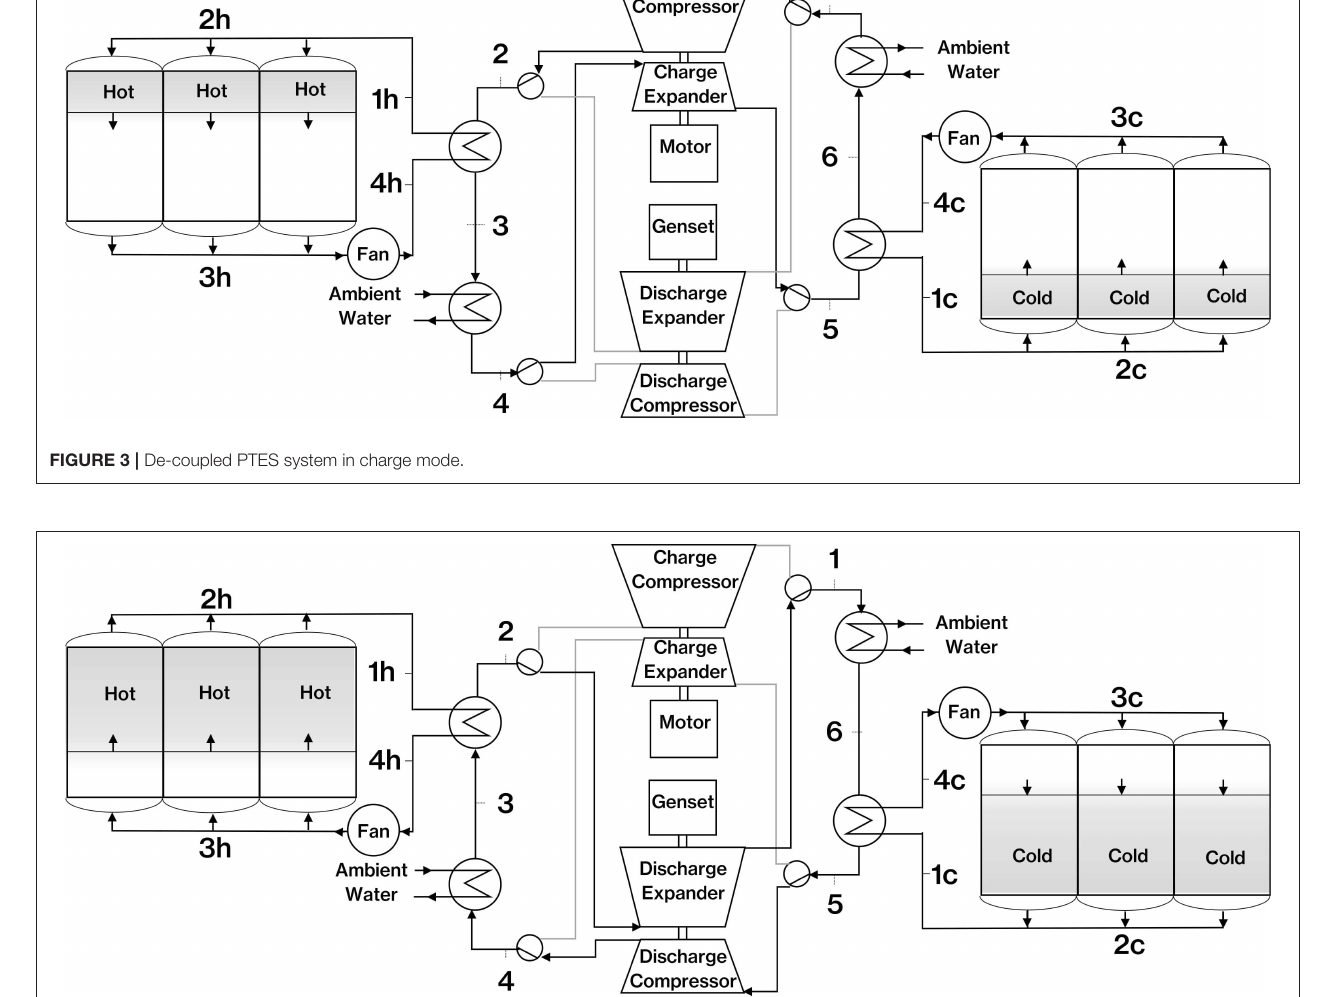
FIGURE 4 | De-coupled PTES system in discharge